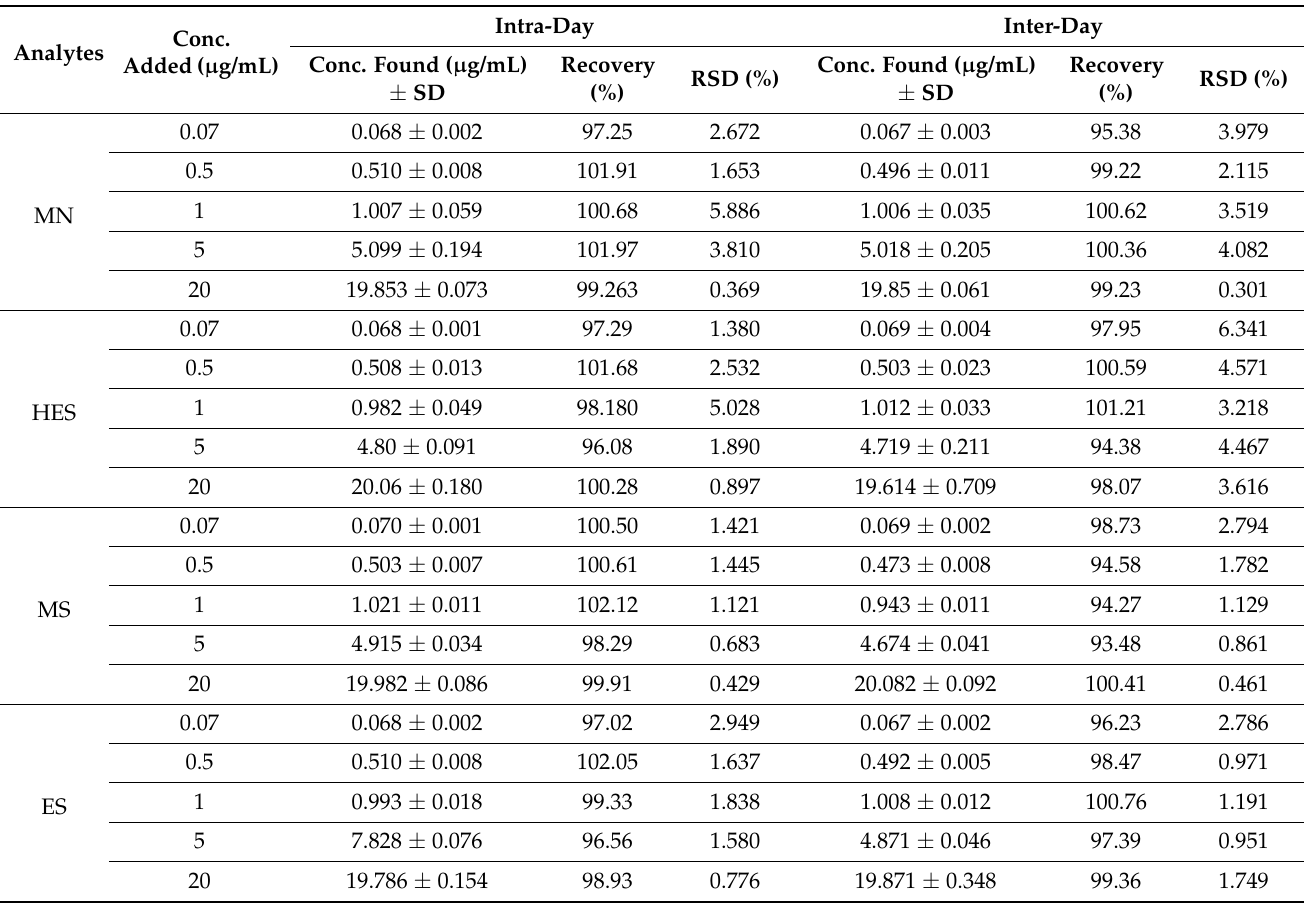
Table 2. Accuracy and precision of the proposed approach for the assessment of MN, HES, MS and